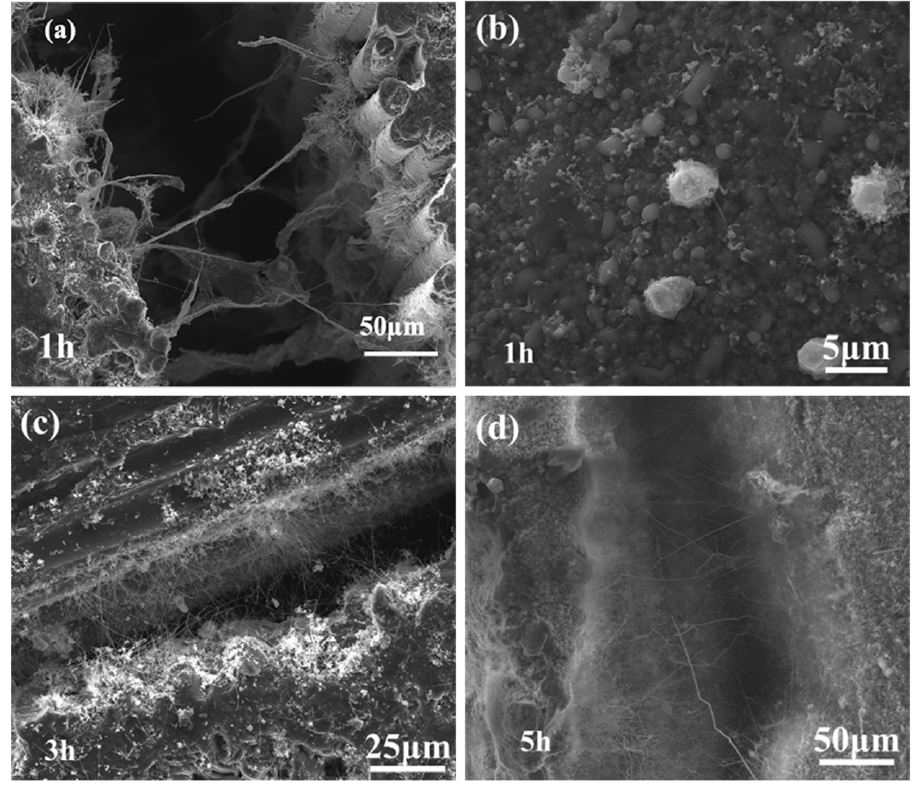
Figure 3. Microstructure of SiCNWs grown via AD method with reaction times of ( a , b ) 1 h, ( c ) 3 h, and ( d ) 5 h.